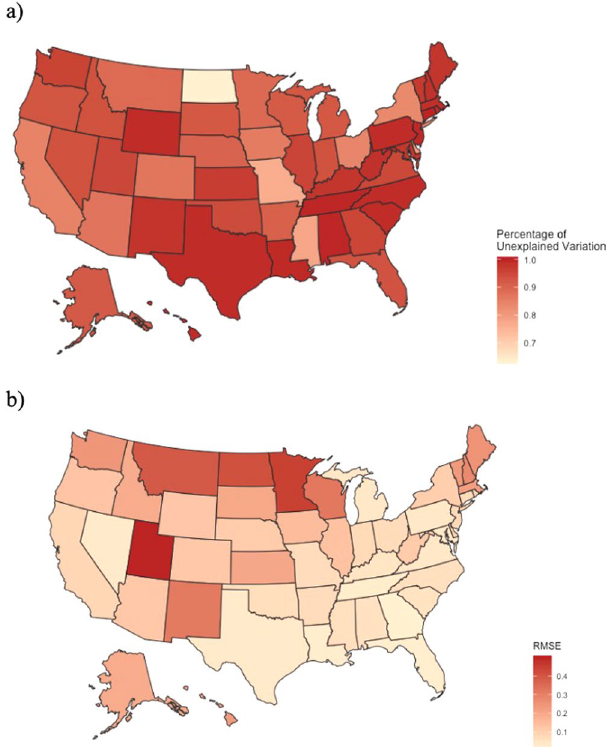
Figure 5. ( a ) Heat map displaying the percentage of unexplained variation (1 − adjusted R 2 ) in the AR(1) AIC ( i ) models spanning the 2004–2010 timeframe in the US. A larger model explanatory power (R 2 ) adjusted * for the number of predictors (adjusted R 2 ) is indicated with lighter shading. ( b ) Is a heat map illustrating the state models’ predictive accuracy (52-week forecasting RMSE in 2011) where lighter shading represents a lower RMSE value and a better performing state AR(1) AIC ( i ) *